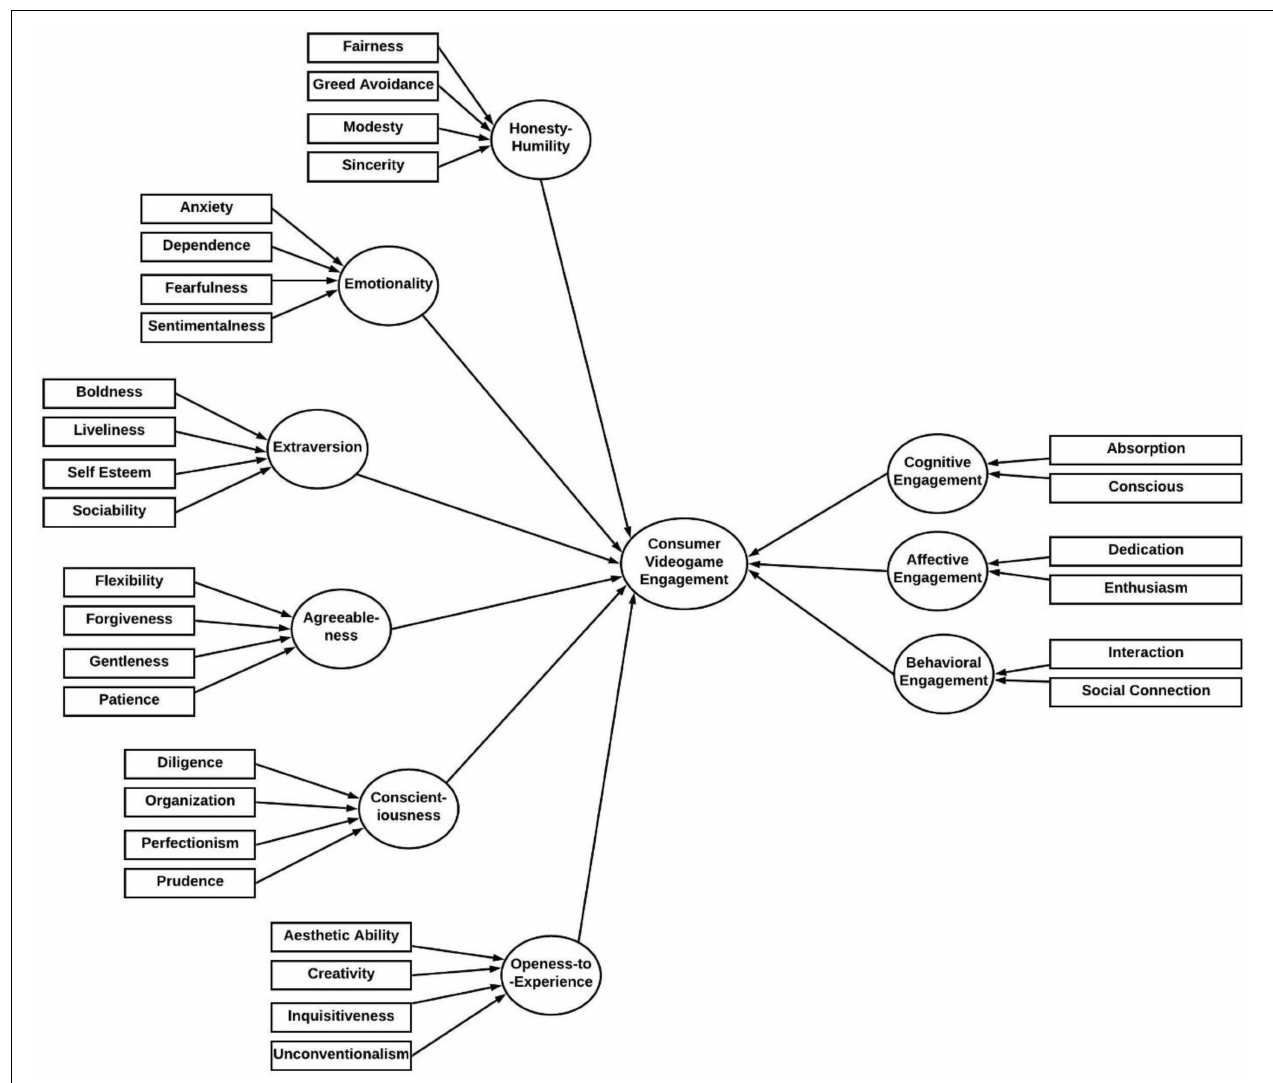
FIGURE 2 | PLS-5EM model specification for measurement model